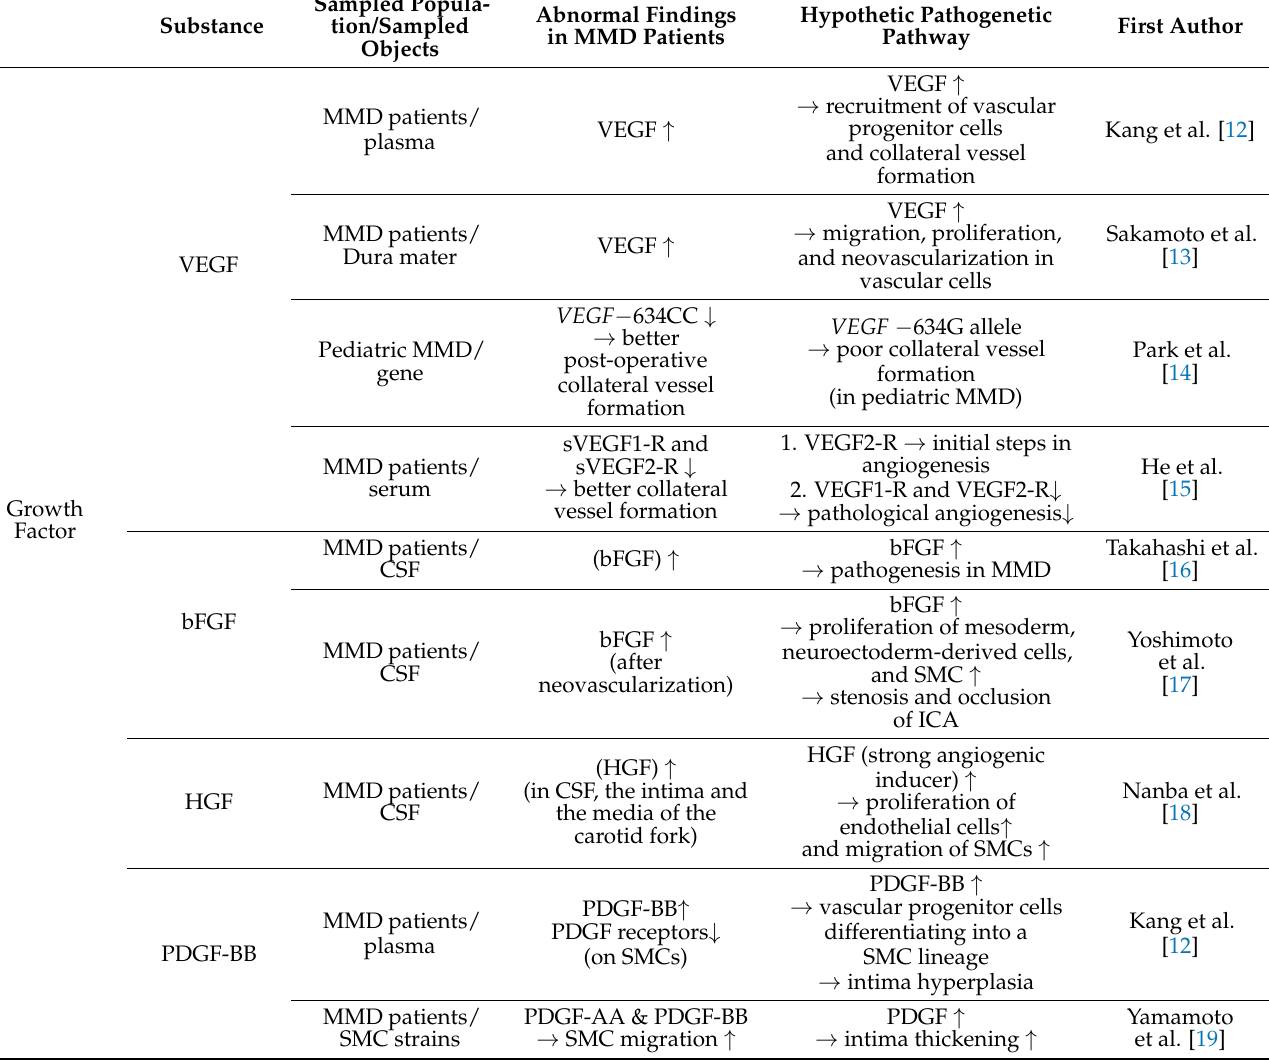
Table 1. Abnormal findings of circulating factors in patients with Moyamoya disease (MMD) and their hypothesized pathological mechanisms. ( ↑ , upregulated; ↓ , downregulated; → , leading to or be related to the consequence in the table. sVEGF1-R, soluble vascular endothelial growth factor 1 receptor; CSF, cerebrospinal fluid; bFGF, basic fibroblast growth factor; HGF, hepatocyte growth factor; PDGF-BB, platelet-derived growth factor-BB; ECFCs, endothelial colony-forming cells; EPCs, endothelial progenitor cells; MCA, middle cerebral artery; CFU, colony-forming unit; RALDH2 ,